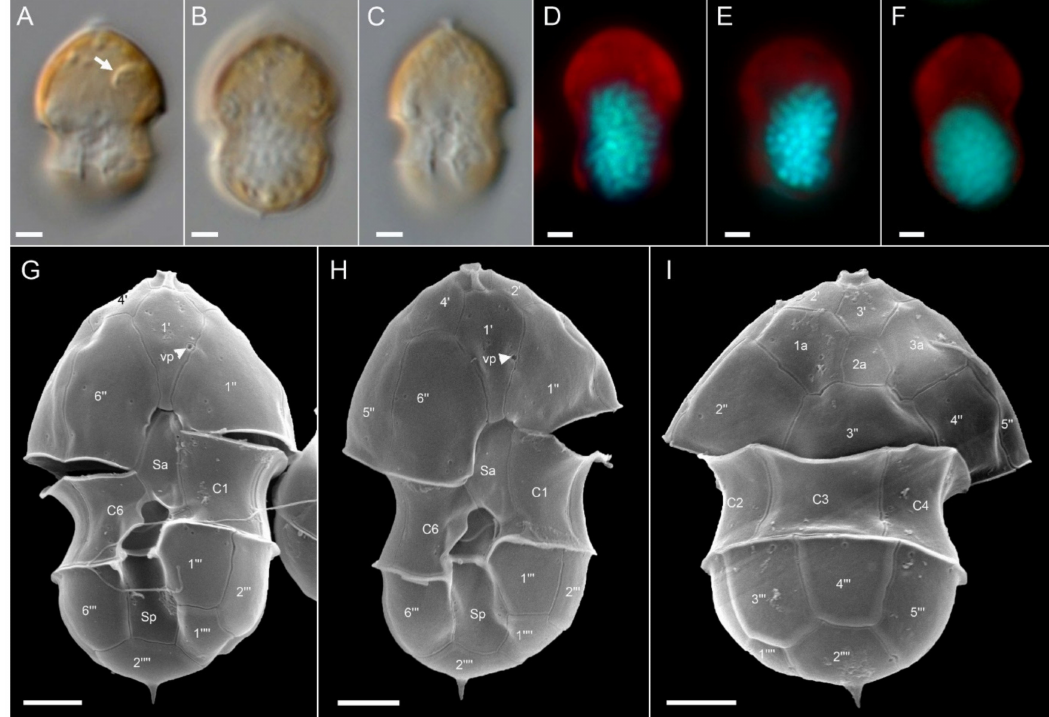
Figure 4. Azadinium spinosum ribotype B strain 5-F6. ( A – F ) LM images of living ( A – C ) cells to indicate general size and shape. Note the distinct pyrenoid in the episome (arrow in A ). ( D – F ) Formalin fixed and DAPI-stained cells viewed with UV excitation to indicate shape and position of the nucleus. ( G – I ) SEM images of different thecae in ventral ( G , H ) or dorsal ( I ) view. Note position of ventral pore (vp). Plate labels according to the Kofoidian system. vp = ventral pore. Abbreviation of sulcal plates: Sa = anterior sulcal plate; Sp = posterior sulcal plate. Scale bars = 2 µ